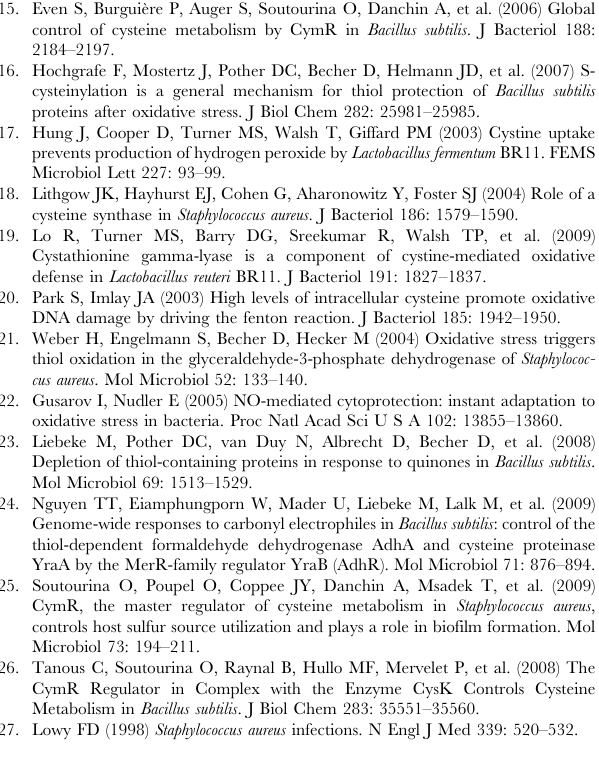
Table S1 Additional stress-regulated genes differentially ex- pressed in the S. aureus D cymR mutant strain compared with strain SH1000. Table S2 Relative expression levels of stress response-associated genes in S. aureus mutant strains compared to SH1000. Table S3 Intracellular metabolite estimation in S. aureus cymR mutant strain compared to SH1000. Table S4 Virulence or host-interaction associated genes differ- entially expressed in the S. aureus D cymR mutant strain compared to SH1000. Table S5 Oligonucleotides used in this